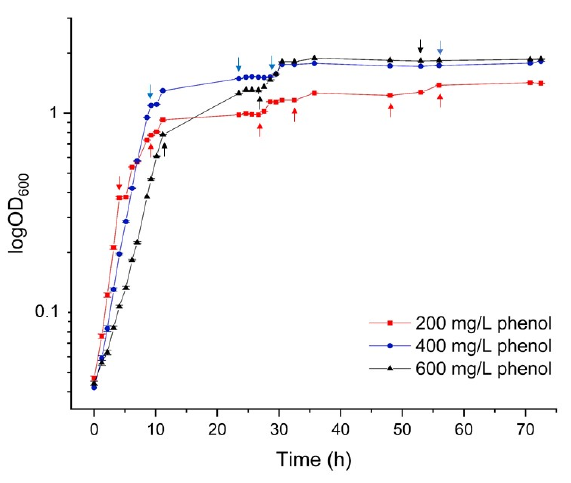
Figure 1. Growth curves of Pseudomonas sp. phDV1 under different concentrations of phenol. The arrows indicate the timepoints of phenol addition.